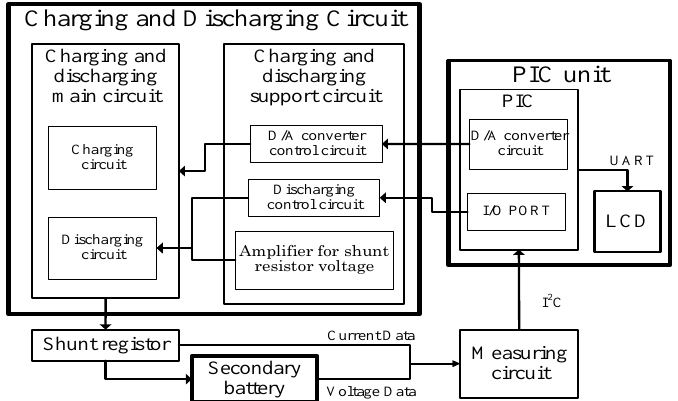
Figure 5. Logic diagram of proposed circuit for charging/discharging battery.